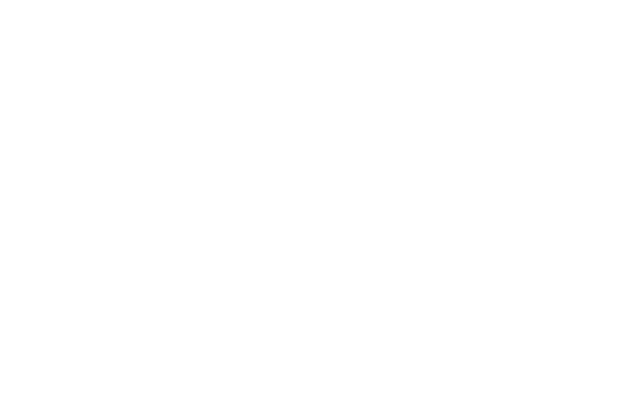
Figure 2. Genes downregulated in shoot tissue of vip double mutants. Venn diagram shows overlap between genes downregulated in all three vip mutants compared to WT. A conserved subset of 20 genes were identified as being downregulated in all the vip double mutants.